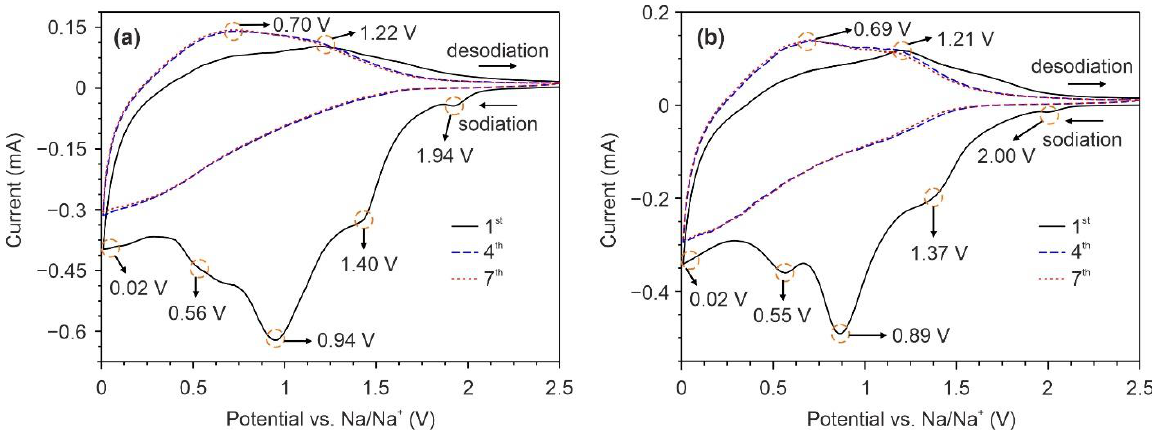
Figure 6. CV curves of NTO-120 ( a ) and NTO-350 ( b ) electrodes registered at a scan rate of 50